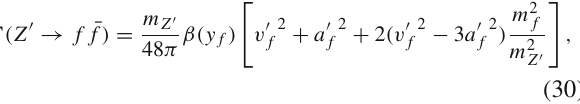
Fig. 3 Decay width of Z (cid:2) normalized by g (cid:2) 2 m Z (cid:2) , (cid:16)( Z (cid:2) )/( g (cid:2) 2 m Z (cid:2) ) for various g (cid:2) as a function of m Z (cid:2) . The blue, yellow and green curves represent the decay into muons, taus and neutrinos, respectively. The brown curve corresponds to the sum of the decay widths. In the figure, the gauge coupling constant is fixed to 10 − 3